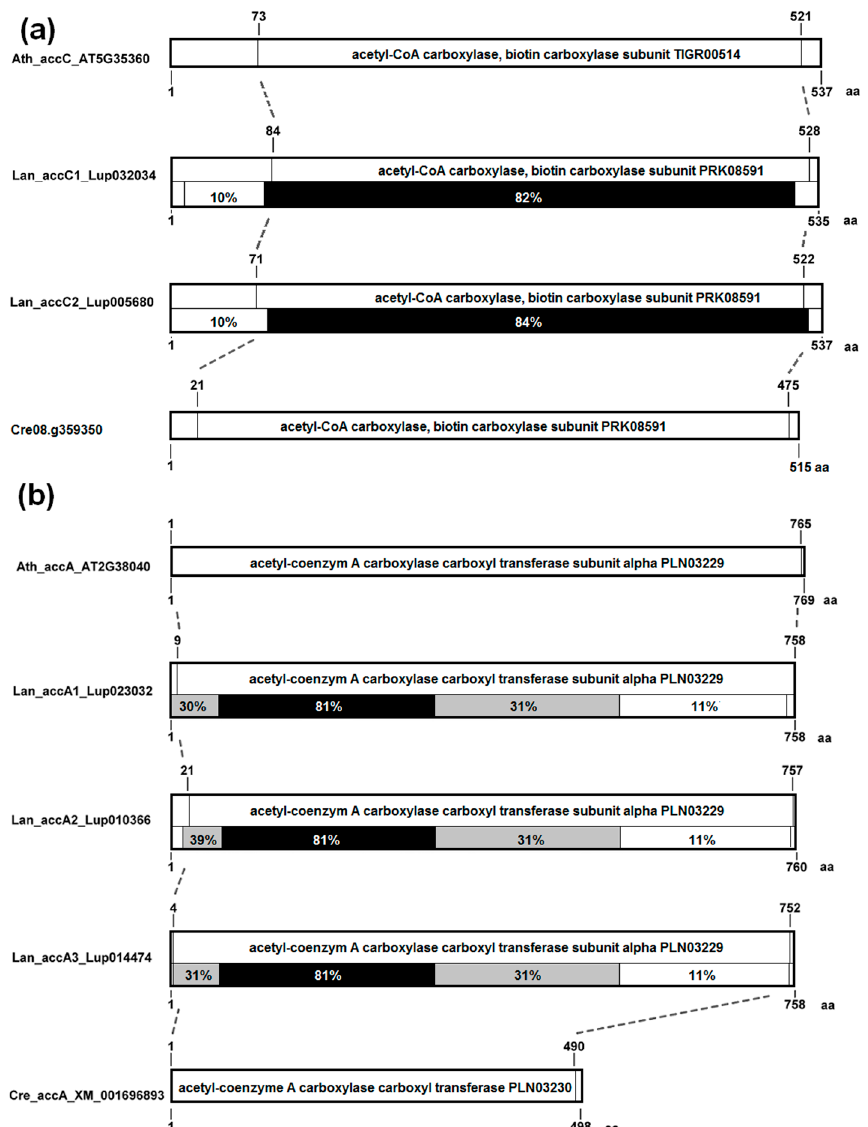
Figure 4. The structure of BC and CT α subunits of plastid ACCase. ( a ) alpha carboxyltransferase, α -CT (gene accA ); ( b ) biotin carboxyl carrier protein, BCCP (gene accB ); ( c ) biotin carboxylase, BC, (gene accC ). Amino acid positions and sequence conservation values are provided. Blocks are colored according to sequence conservation level, namely: white, 4–19%; light grey, 20–59%; dark grey, 60–79%; black, 80–100%. Legume sequences used for calculation are provided in Tables S12 and